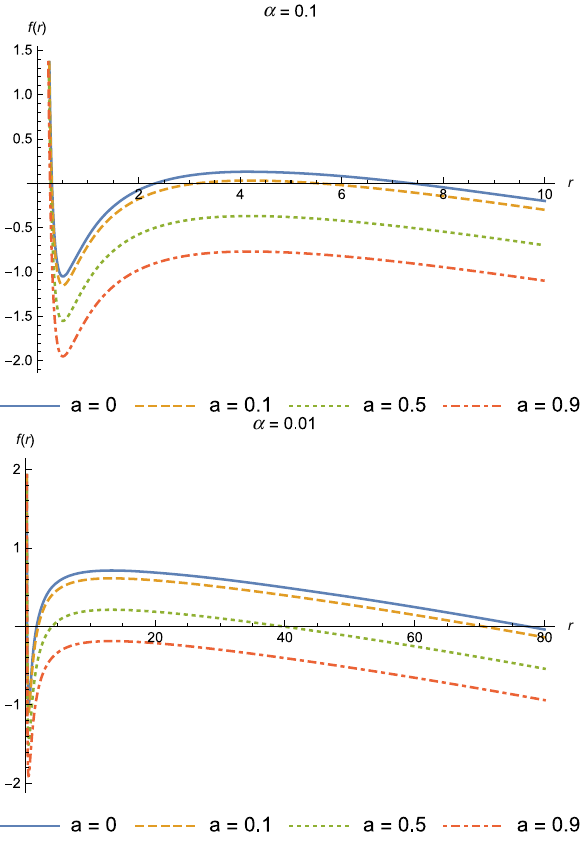
Fig. 1 The function f ( r ) for different values of a and α . We choose M = 1 and Q 2 = 0 . 5